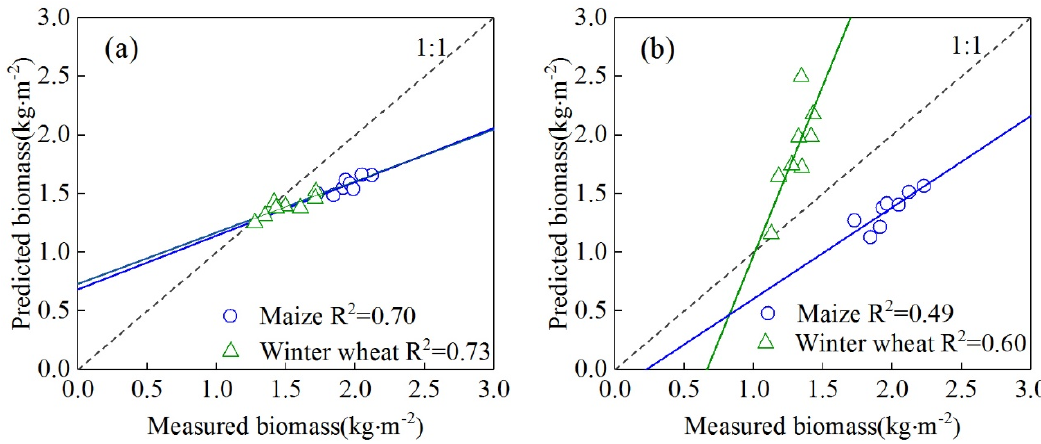
Figure 11. Correlation of the aboveground biomass of winter wheat and maize in the main growing seasons.